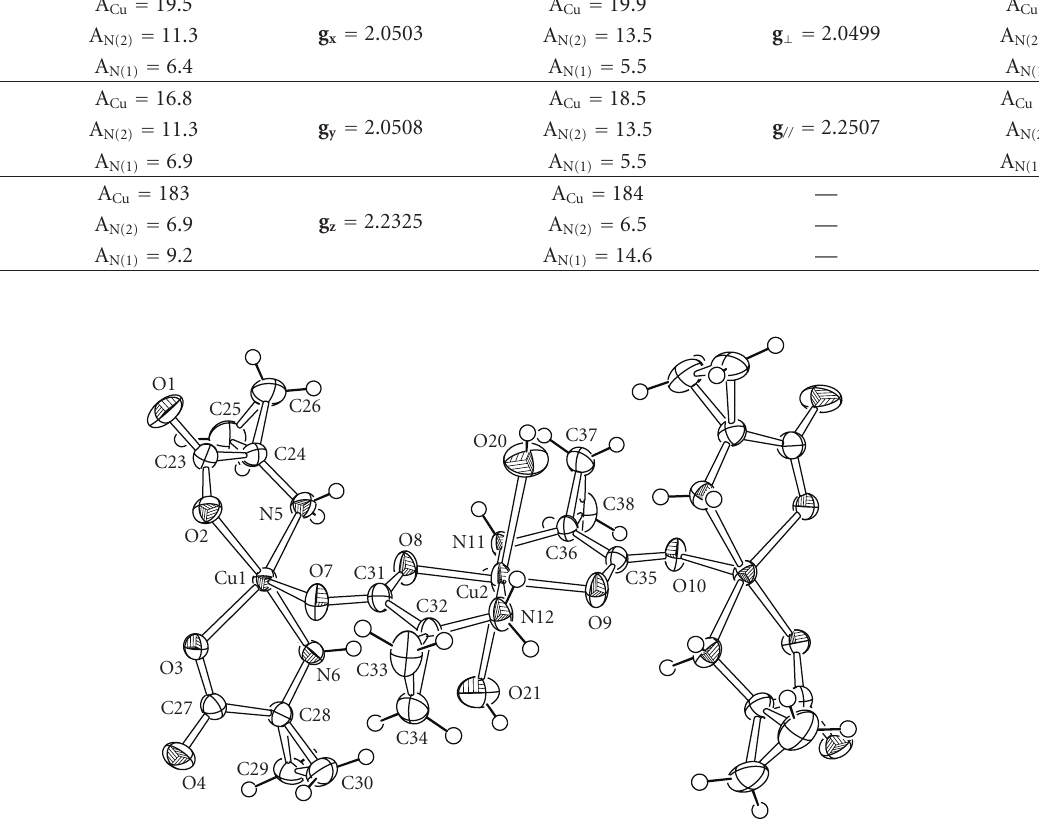
Figure 2: ORTEP drawing of 2